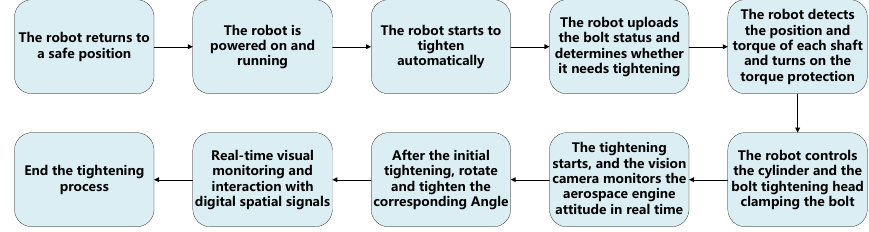
Figure 19. Robot tightening flow chart. Figure 20 is an experimental diagram of a robot tightening a bolt in a physical